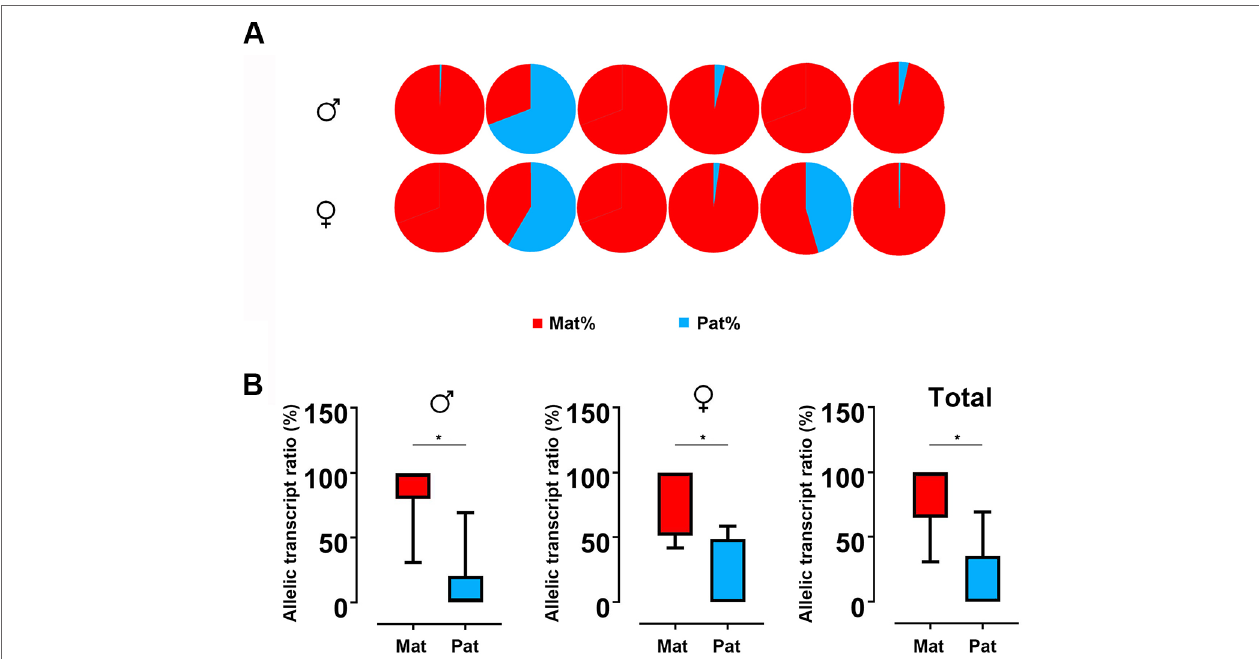
FIGURE 4 | ASE analyses of GH in hybrid. (A) Asymmetric allelic expression of GH in male hybrids and female hybrids by pyrosequencing. Six individuals of male hybrids and six female hybrids were included based on the C/G SNP site (nucleotide 501). (B) Allelic transcript ratios of C/G in hybrid calculated from males (n = 6), females (n = 6) and total studied individuals (n = 12). Data are presented as the mean ± SEM. Asterisks indicate significant differences between groups ( P < 0.05). Mat, maternal; Pat, parental.